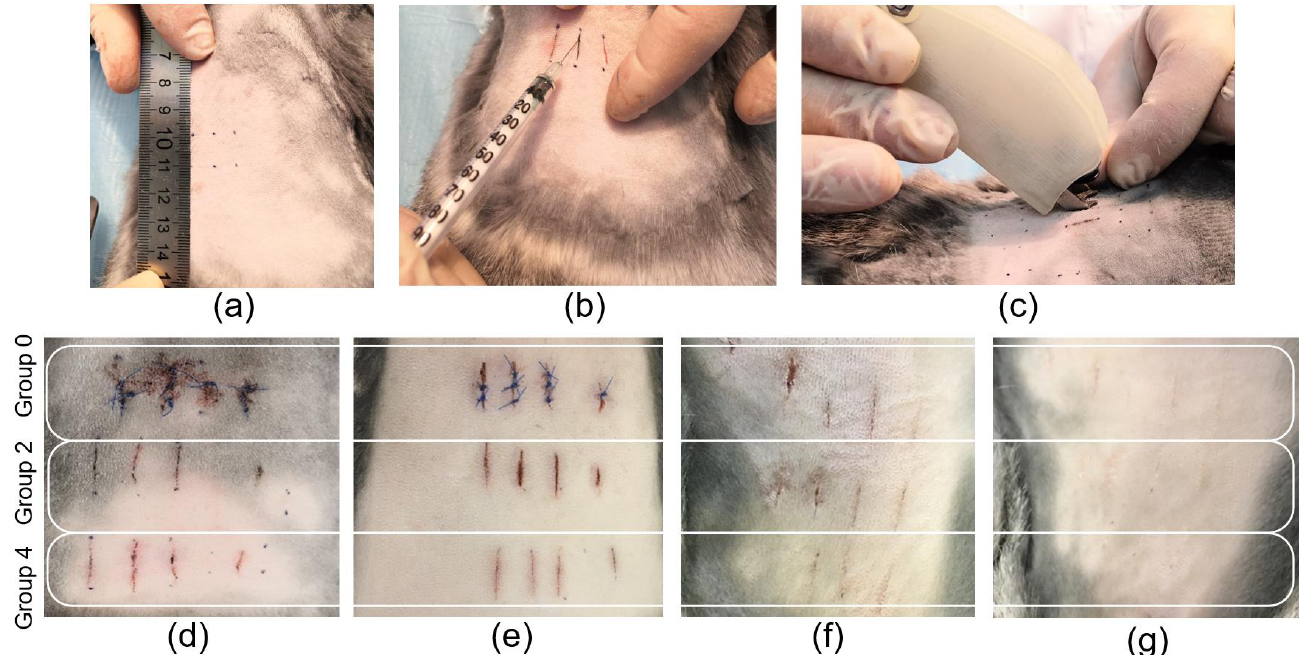
Figure 2. Photos of rabbit skin reconstruction in vivo: marking for dissection ( a ), solder application to the wound ( b ), laser formation of the weld ( c ). Photos of traditional suture (group 0) and laser welds BSA+ICG solder (group 2) and BSA+ICG+SWCNT (group 4) on 1 ( d ), 3 ( e ), 7 ( f ), 10 ( g ) postoperative days.